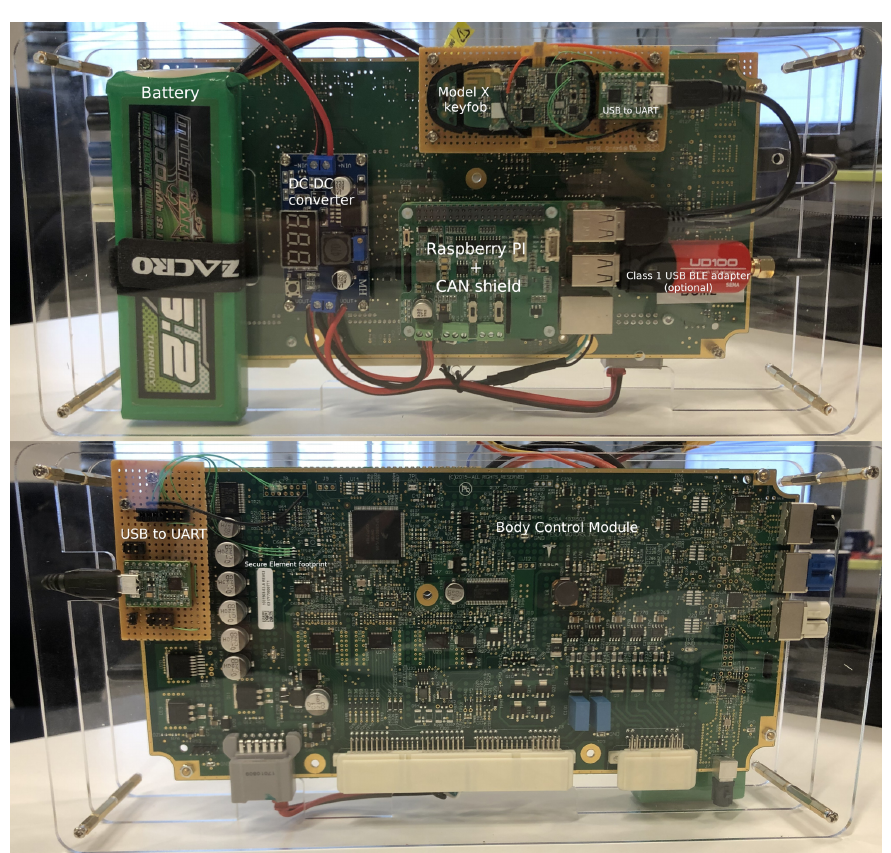
Figure 8: The PoC device consists of a battery and a DC-DC converter that is used to power the Raspberry Pi Model 3b+ with a 2-Channel CAN-BUS shield and the modified